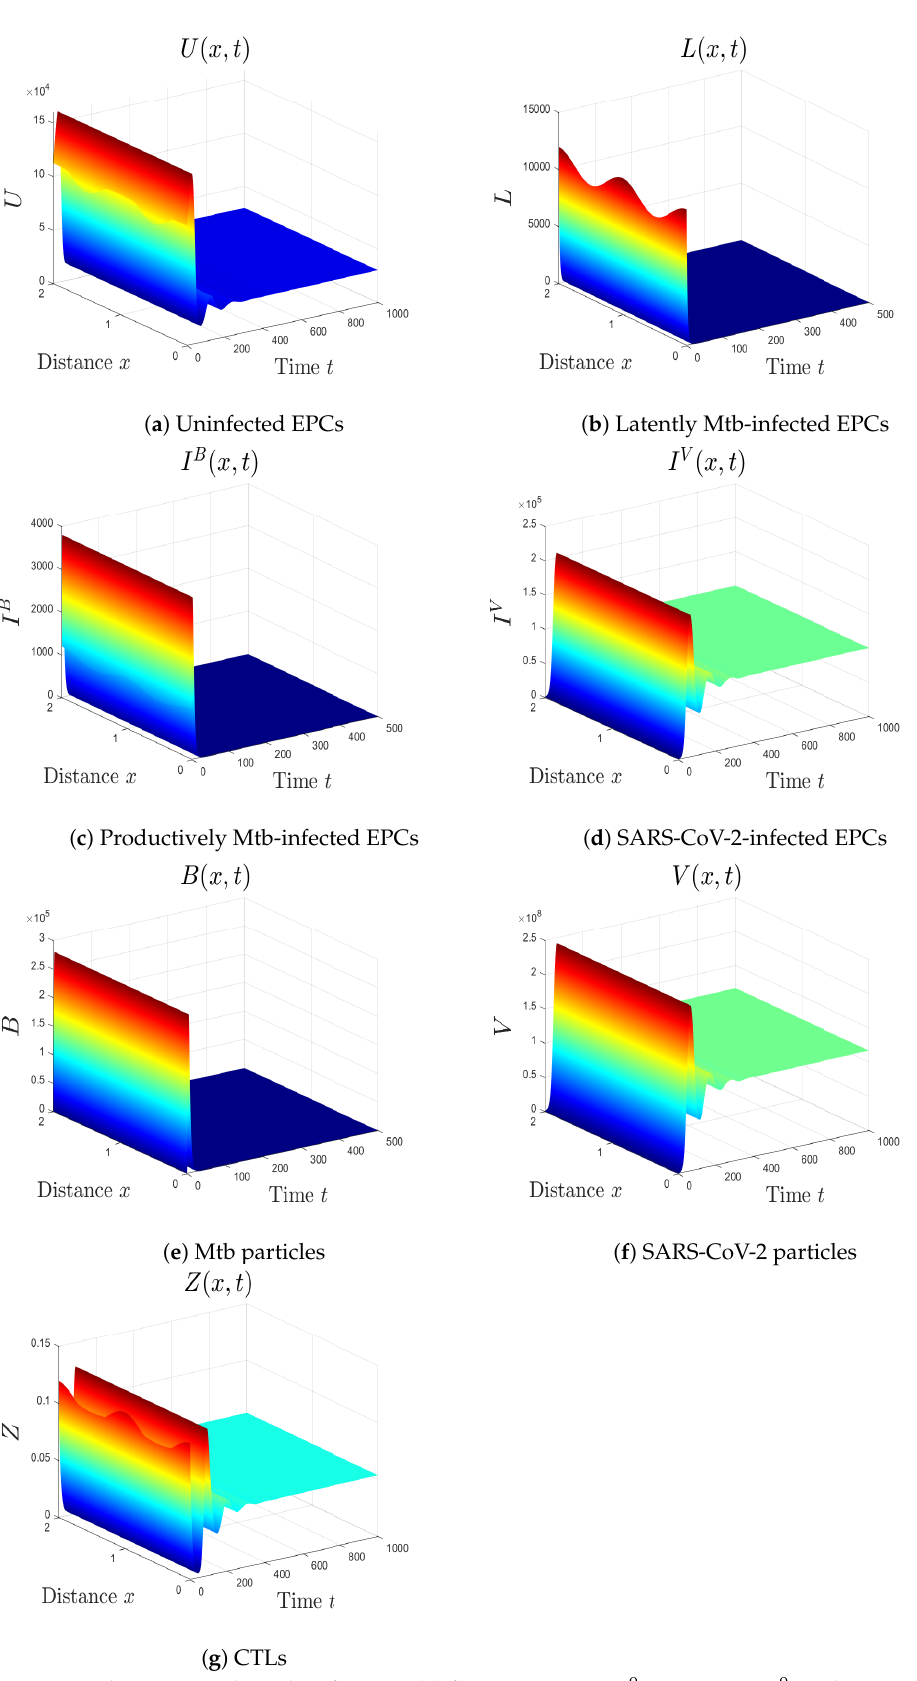
Figure 5. The numerical results of system (1) for η 1 = 2.5 × 10 − 9 , η 2 = 1 × 10 − 9 , and ω = 1 × 10 − 6 . (cid:0) The equilibrium E 4 = 31,578.9,0,0,1 × 10 5 ,0,1.16667 × 10 8 ,0.0536842